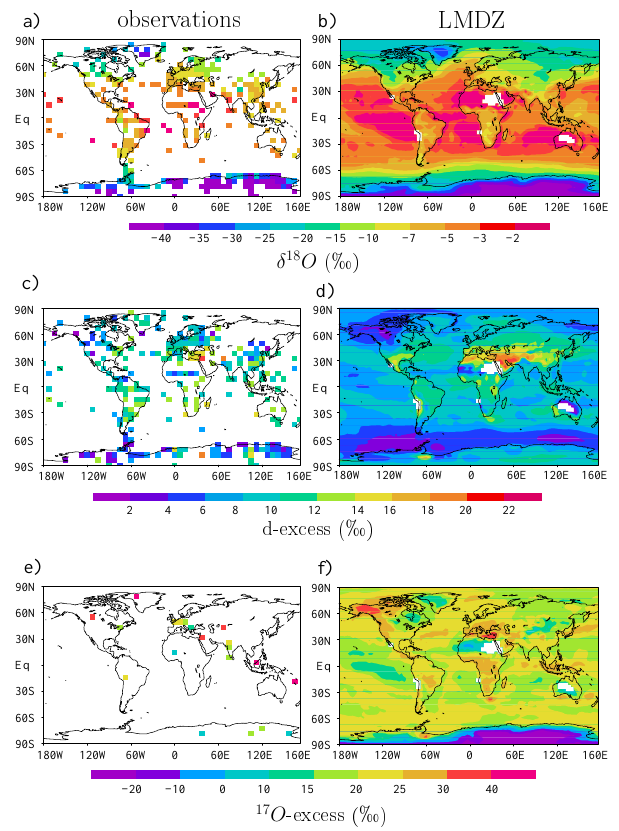
Fig. 3. Annual mean of precipitation δ 18 O , d-excess and 17 O -excess simulated by LMDZ and observed by the GNIP network and various observations listed in Tables 1 and 2.